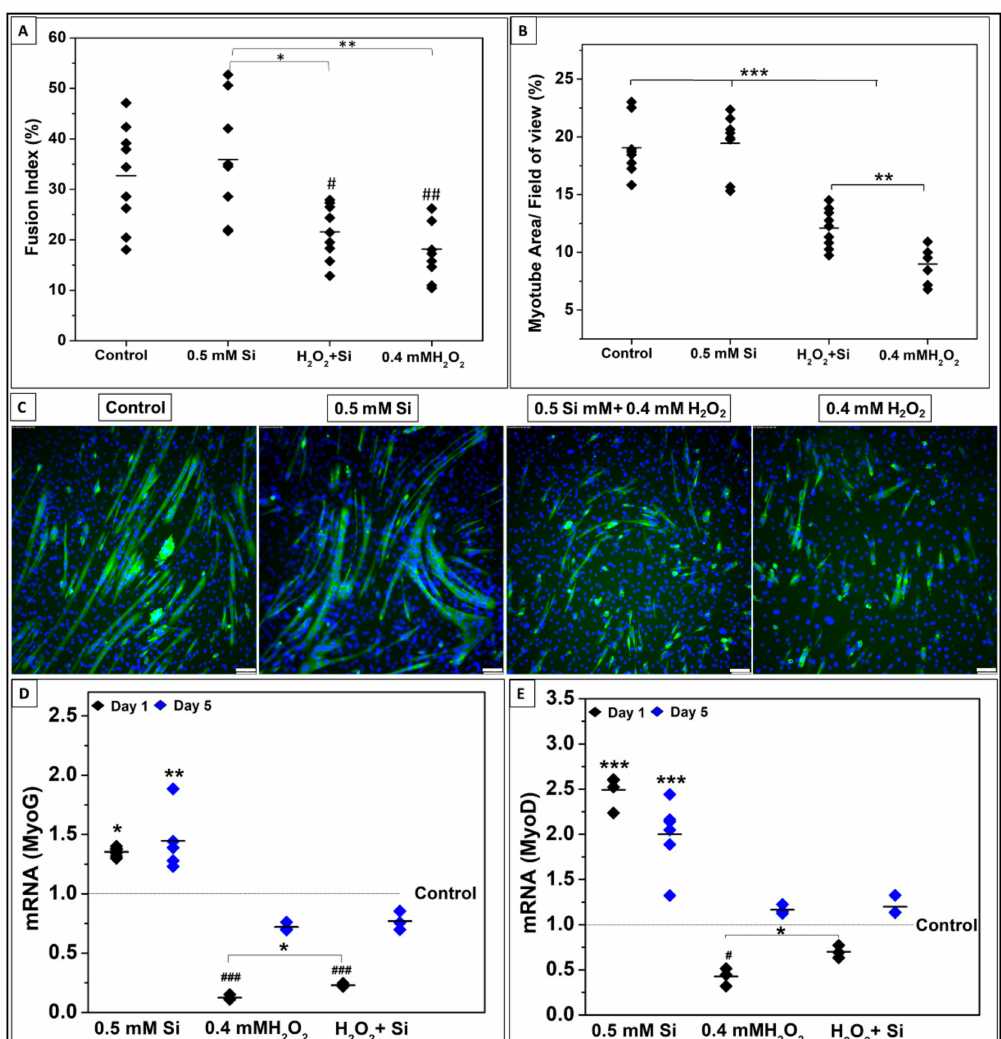
Figure 8. Effects of Si-ions concentration on C2C12 myoblast cells after 4 days of differentiation under oxidative stress (0.4 mM H 2 O 2 ). ( A ) Data distribution graph shows the Fusion index (FI) after 4 days of differentiation comparing the differentiation under 0.4 mM H 2 O 2 to 0.4 mM H 2 O 2 + 0.5 mM Si and the control. Adding 0.5 mM Si increases the FI compared to 0.4 mM H 2 O 2 , but no significance deference was observed. ( B ) Area covered by myotubes (%) indicated that addition of 0.5 mM Si increase the total area of myotubes compared to 0.4 mM H 2 O 2 by reliving the cells from the toxic oxidative stress. ( C ) Fluorescence images of DAPI-stained nuclei (blue) and myosin heavy chain antibody (MHC, green)-stained myocytes/myotubes of C2C12 myoblasts on the tissue culture plate (TCP) as a control, 0.5 mM Si-ions, 0.4 mM H 2 O 2 + 0.5 mM Si, and 0.4 mM H 2 O 2 after 4 days of differentiation, Scale bar is 100 µ m, 10-X magnification. ( D , E ) Myogenic determination protein (MyoD) and Myogenin (MyoG) genes expression at 1 and 5 days of C2C12 cell differentiation under ROS conditions. The * was used to show the significant increase (* p < 0.05, ** p < 0.01, *** p < 0.001) while # shows the significant decrease (# p < 0.05, ## p < 0.01, ### p <